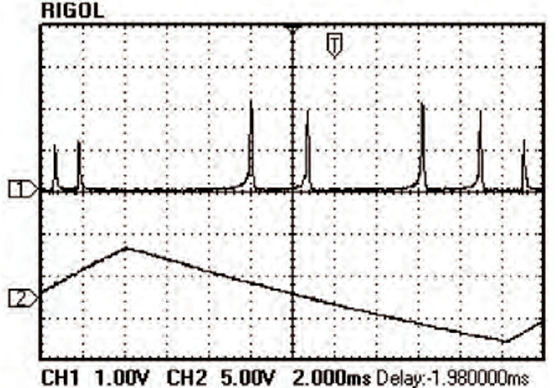
Figure 26. Mode patterns of simultaneous dual-frequency oscillation [35].